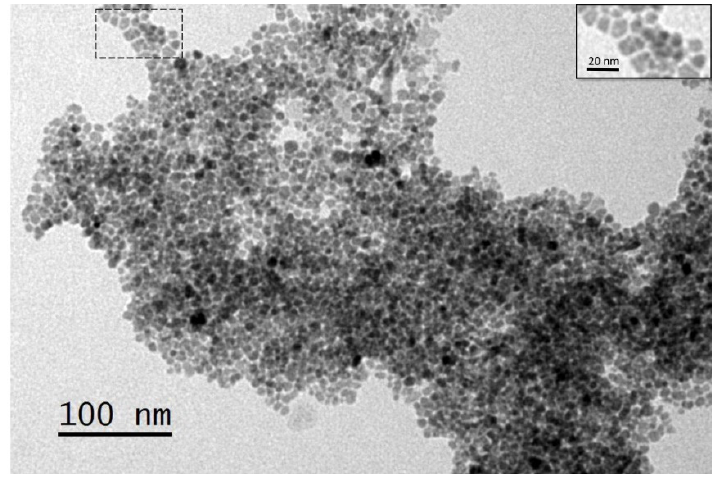
Figure 5. TEM micrograph of Au-CoFe 2 O 4 mCSNPs, exhibiting monodisperse NPs of size 5–10 nm.